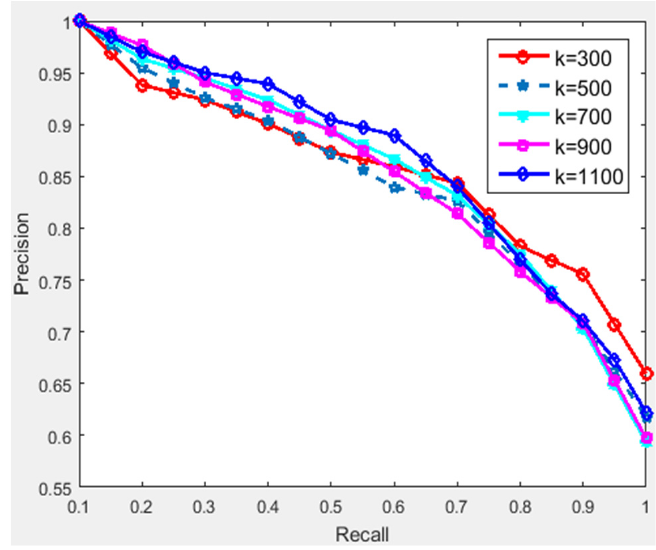
Figure 6. PR curve of different codebook size 𝑘 .